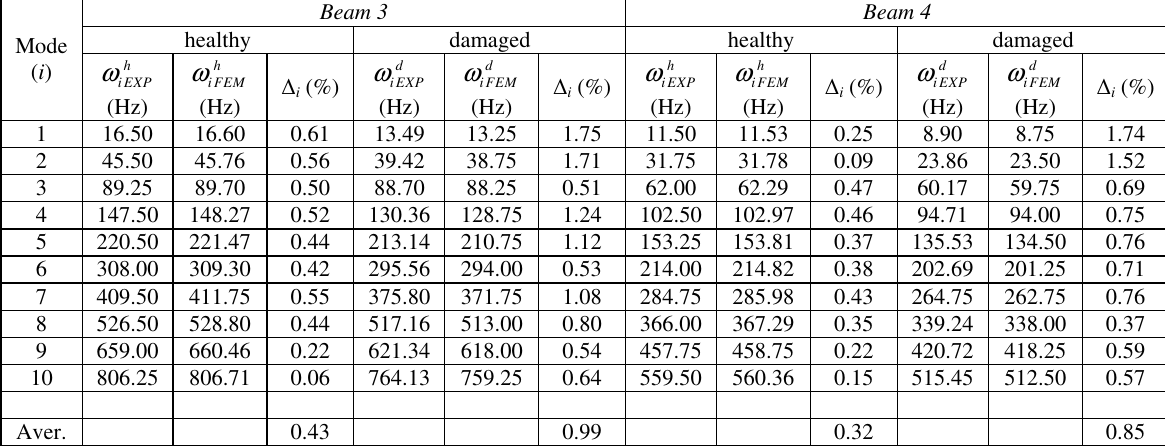
Table 4. Flexural frequencies and residuals for the Beam 3 and the Beam 4 with FF boundary conditions